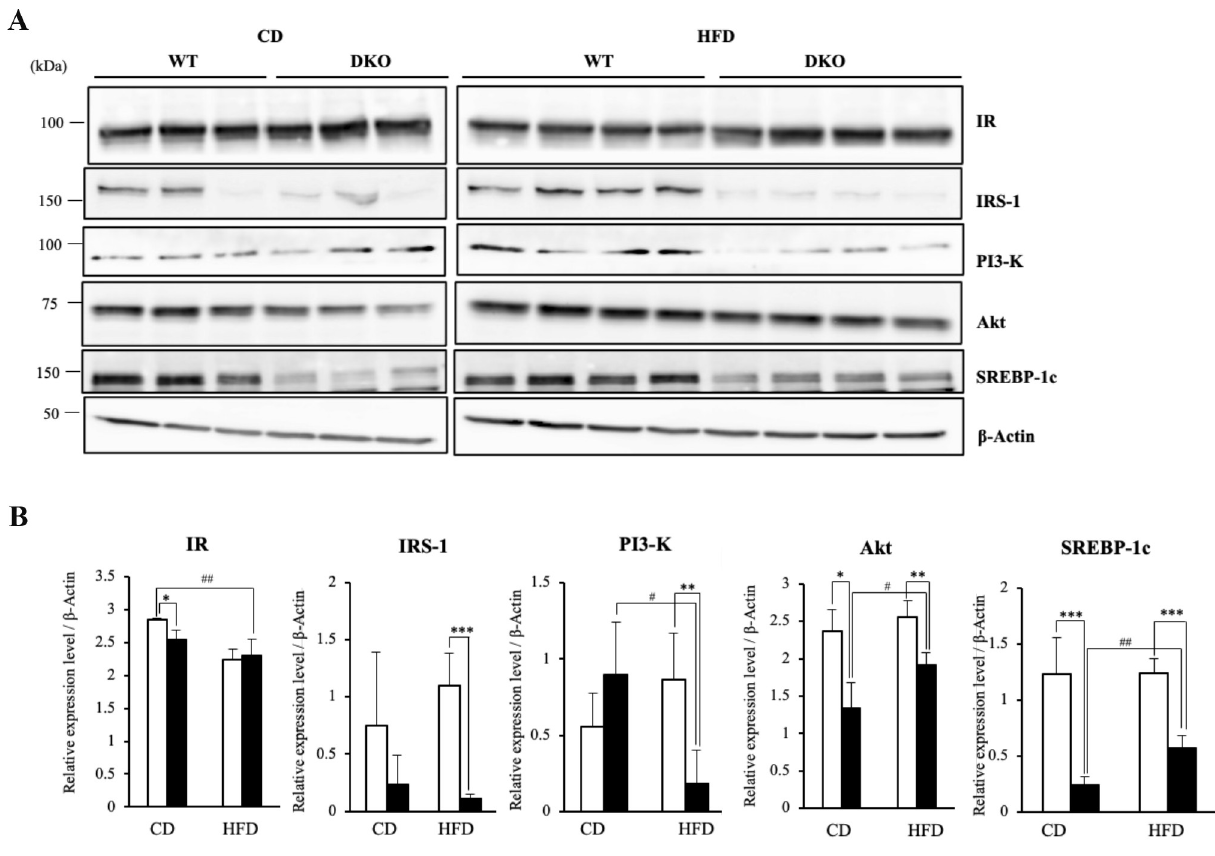
Fig 5. Expression levels of insulin signaling pathway-related proteins were reduced in livers of HFD-fed DKO mice compared with WT mice. ( A ) Protein levels of insulin signaling pathway-related molecules in livers of CD-fed (3 mice each) or HFD-fed (4 mice each) mice were analyzed by immunoblotting. ( B ) Relative expression levels are presented by measuring band intensities after correction with those of β -Actin. Open and closed bars indicate WT and DKO mice, respectively. Data are expressed as means ± S.D. � P < 0.05, �� P < 0.01 and ��� P < 0.001 as compared between WT and DKO mice. # P < 0.05 and ## P < 0.01 as compared between CD and HFD